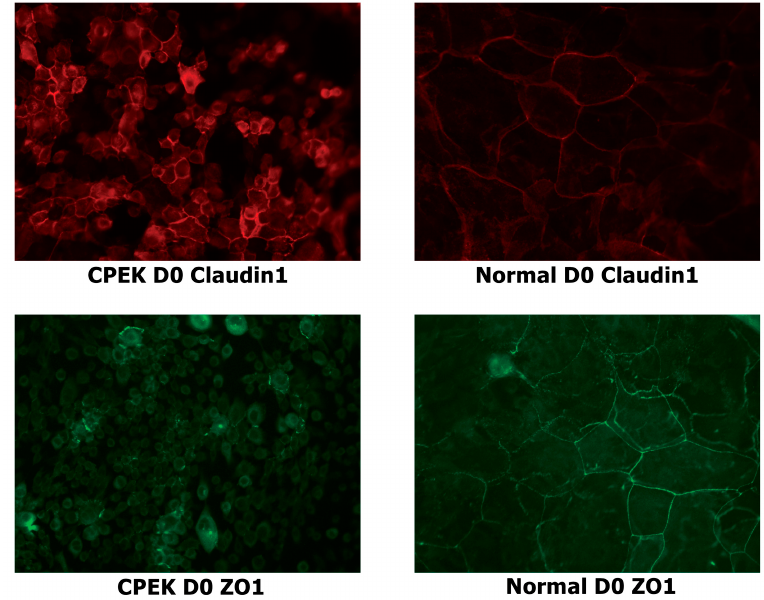
Figure 4. Stained canine progenitor epidermal keratinocyte (CPEK) cells and normal keratinocytes at day 0 of confluence. Normal keratinocytes have larger size and variation in size while CPEKs are visibly smaller. Claudin-1 staining is more intense in CPEK than Normal. ZO-1 immunofluorescent staining is cytoplasmic in CPEKs while is primarily on the cytoplasmic membrane in normal keratinocytes. Images were taken at 40x.